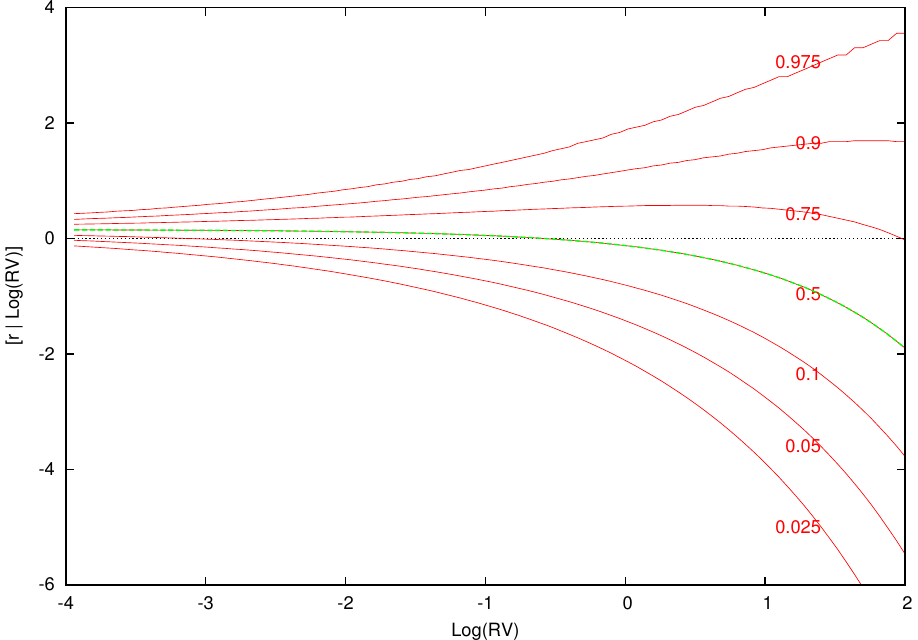
Figure 10. Quantiles of excess returns given log ( RV ) for the parametric model. This figure displays the quantiles of the distribution of excess returns conditional on log ( RV ) for the parametric model. The green dotted line is the expected excess return given log ( RV )